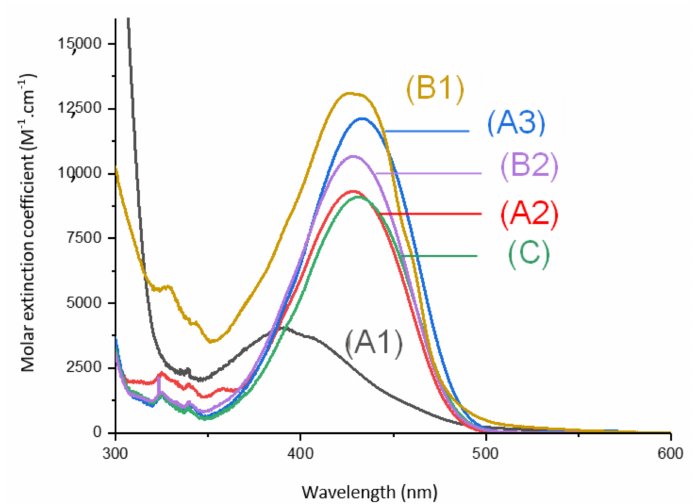
Figure 1. UV-visible absorption spectra of (1) Napht-A1, (2) Napht-A2, (3) Napht-A3, (4) Napht-B2, (5) Napht-C, (6) Napht-B1; in